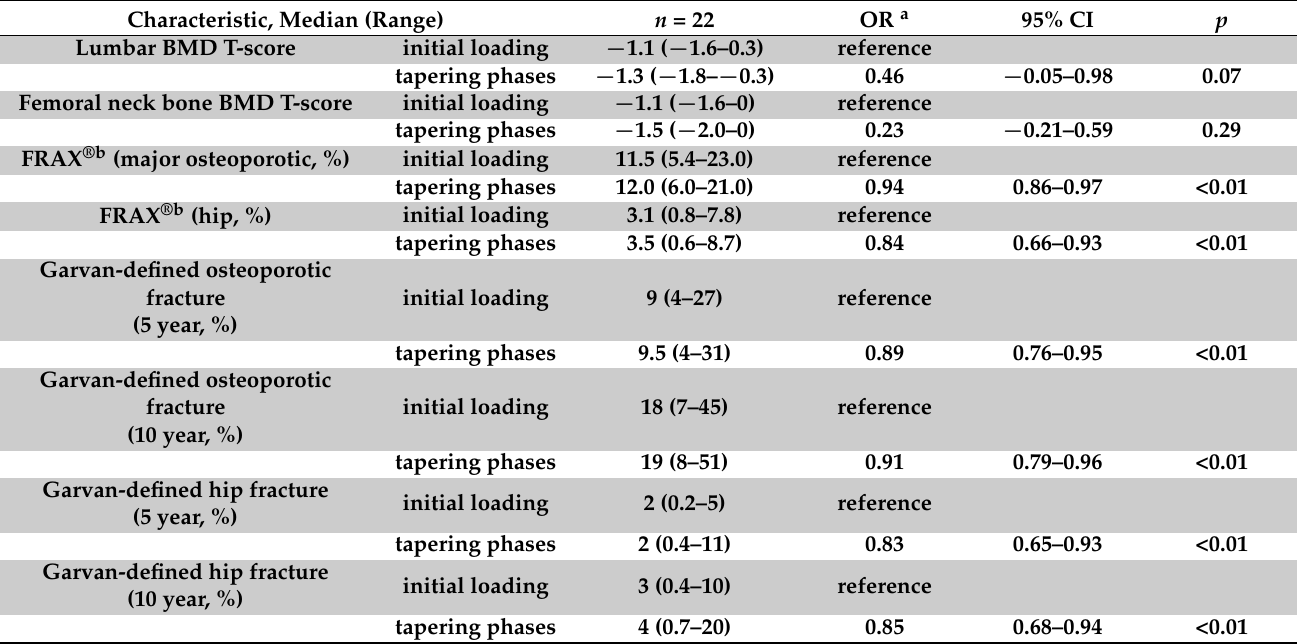
Table 2. Score change during the initial prednisolone administration.